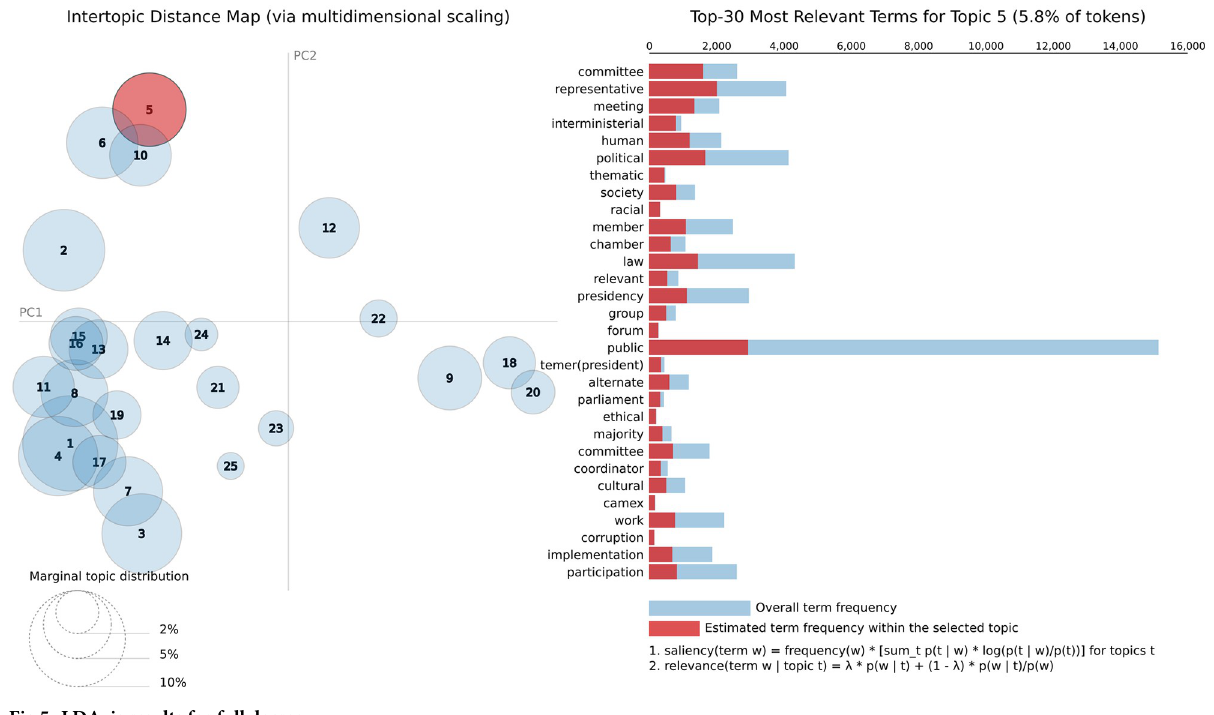
Fig 5. LDAvis results for full decree.